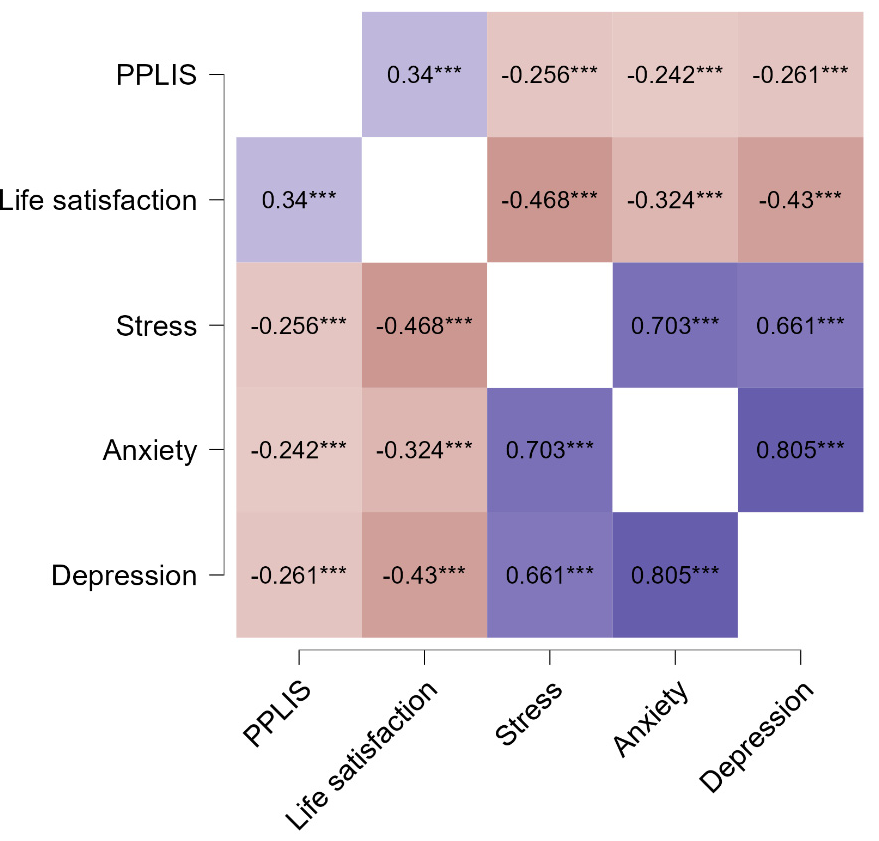
Figure 2. Pearson’s correlations between the perceived positive lockdown impact scale (PPLIS) and well-being dimensions: life satisfaction, perceived stress, anxiety, and depression. N = 3230, *** p < 0.001. Violet represents a positive correlation and red a negative correlation. Table 2. Multiple linear regression for life satisfaction ( N = 3230).